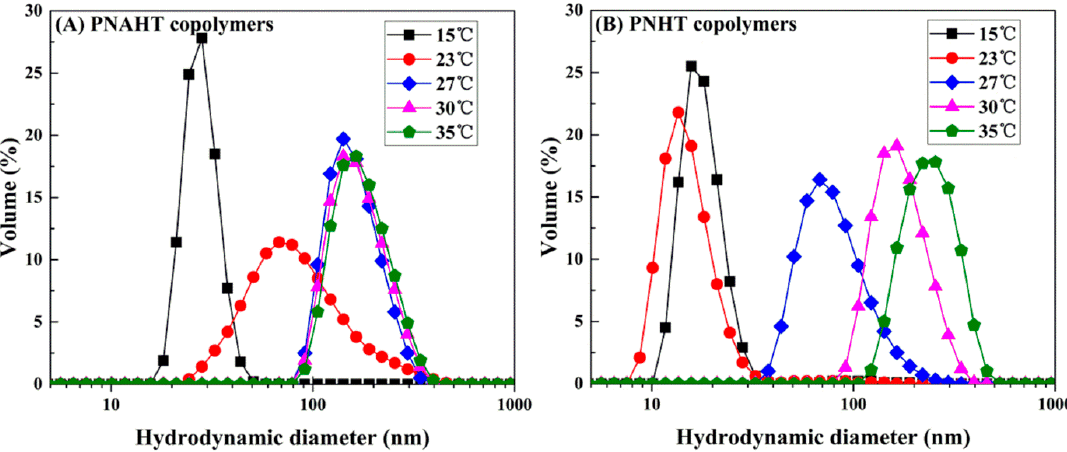
Figure 4. Typical D H distributions of PNAHT ( A ) and PNHT ( B ) copolymers in UHQ water at different temperatures.